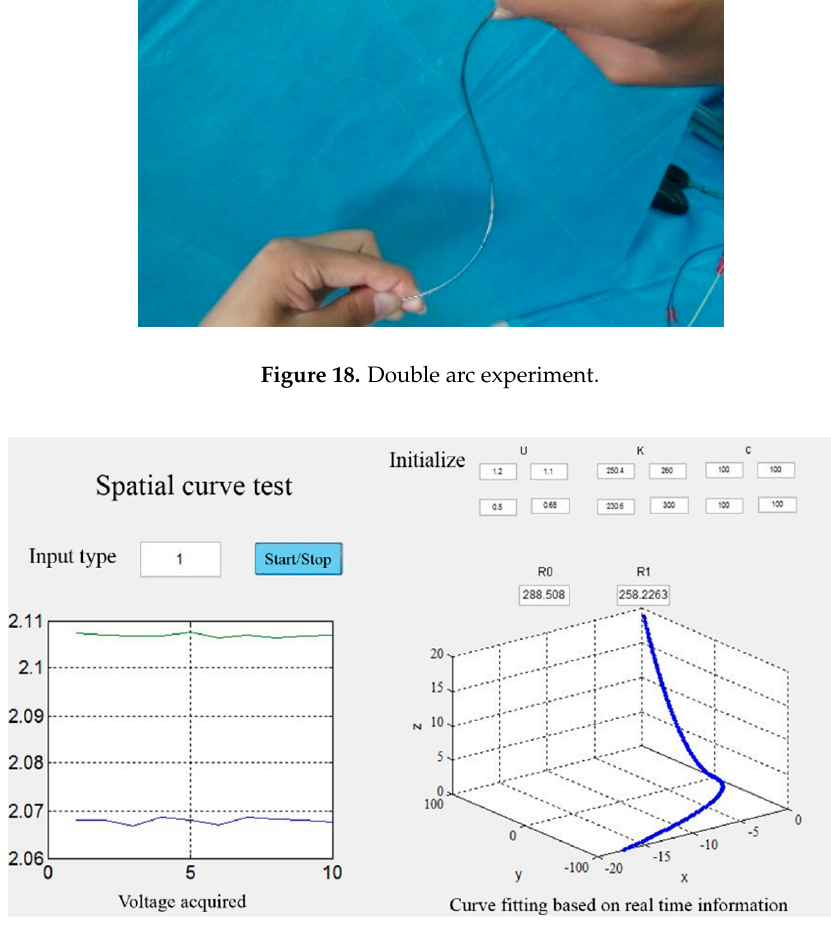
Figure 19. Experiment results.